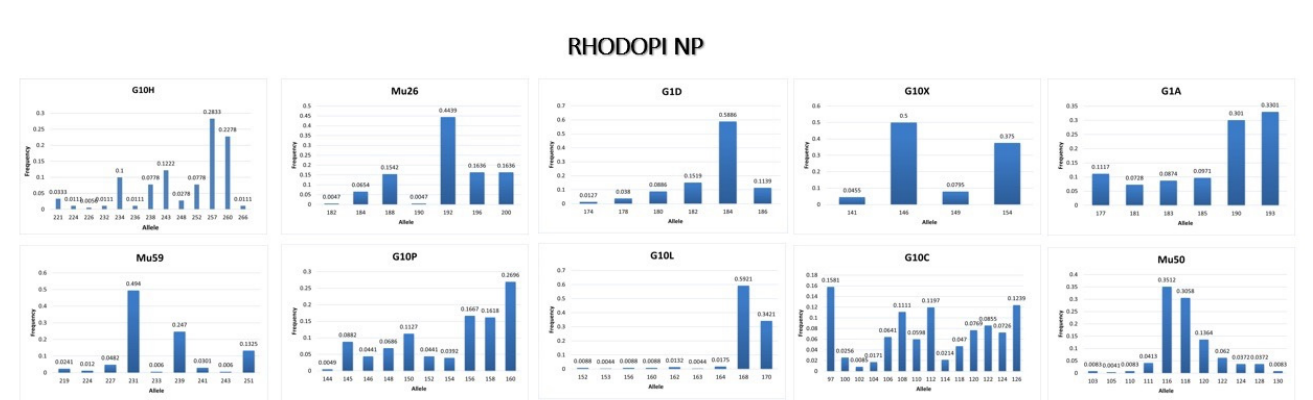
Figure 5. Allele frequency of each microsatellite locus of the brown bear population in Rhodopi NP. Table 6. Number of homozygotes, heterozygotes, and alleles that are present at each locus (Rhodopi NP).